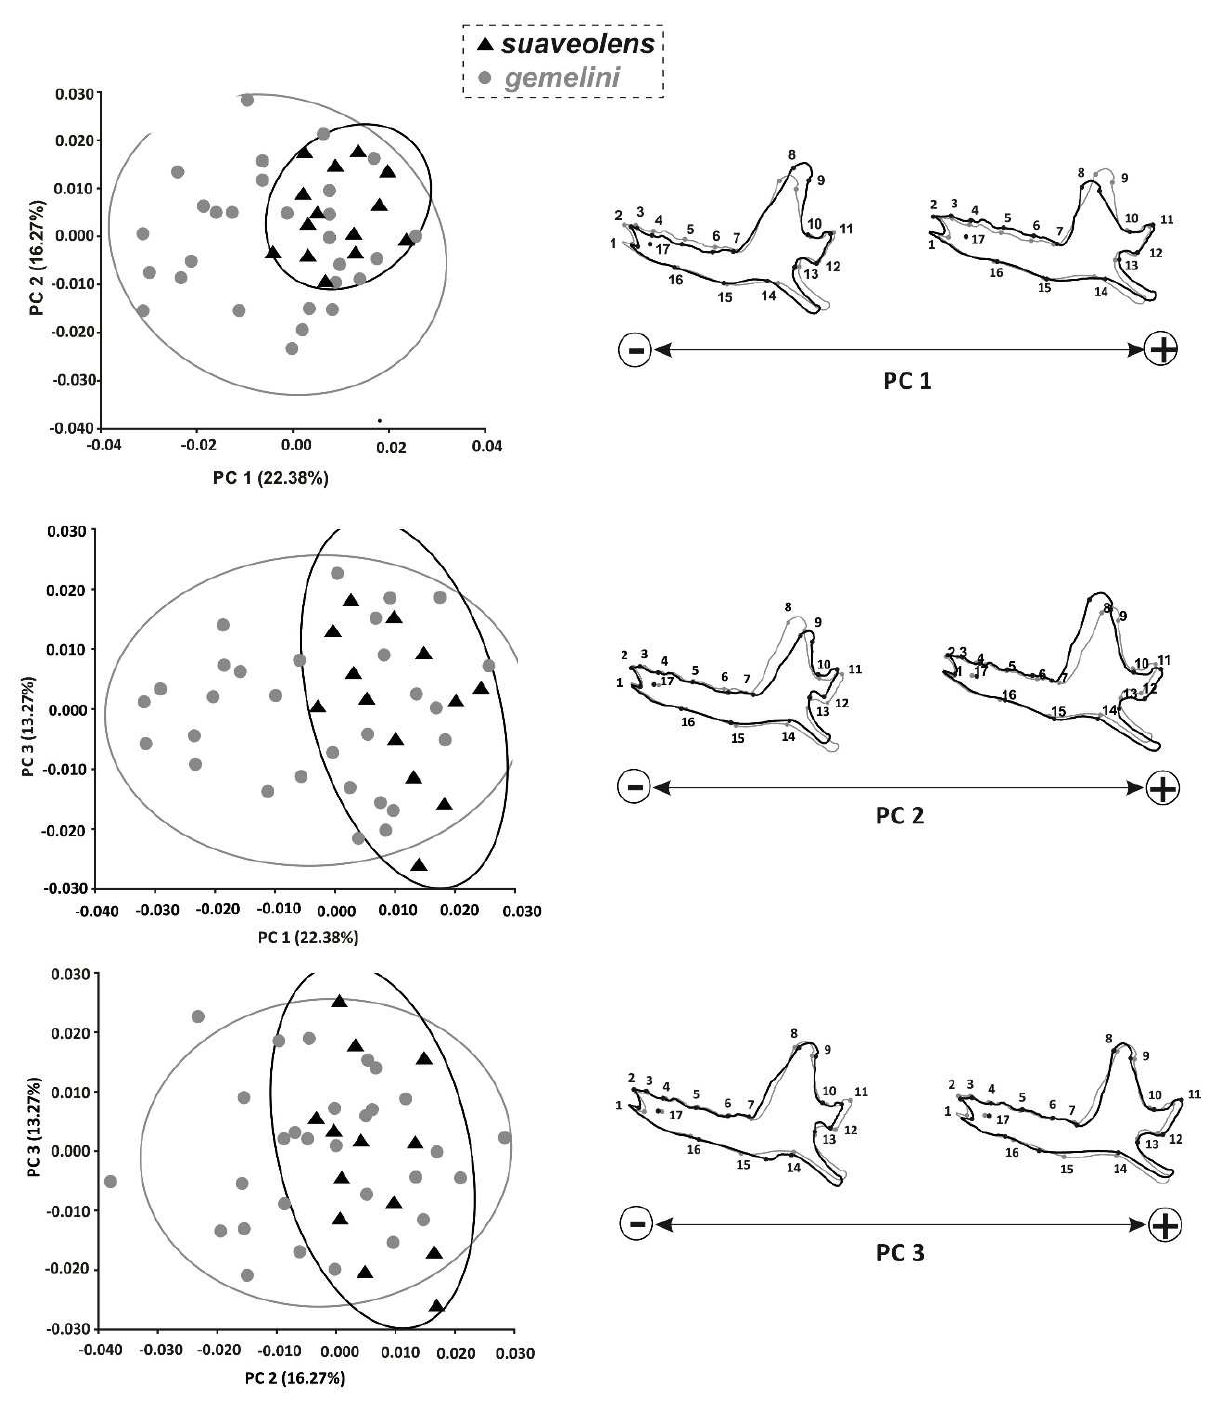
F IGURE 3. The scatter plots of the first three PCs with 95% equal frequency ellipses for suaveolens and gmelini from Iran. The percentage of explained variance are given in